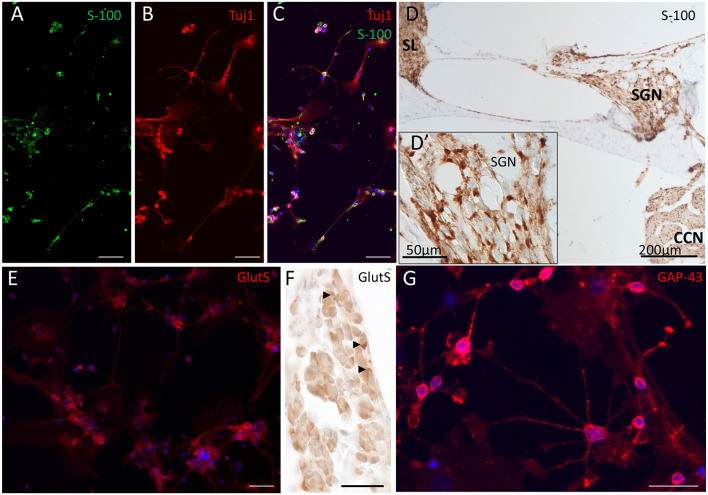
Glial marker expression in differentiated phoenix cells. (A–C) Beta-III-tubulin and S-100 staining 3 days after seeding of phoenix auditory neuroprogenitors. (A) S-100 (green). (B) Beta-III-tubulin (TUBB; red). (C) Composite image with DAPI nuclei staining. (D) S-100 staining in mouse pups cochlear slices. (D′) Inset represents a magnified view of the SGN area and identify Schwann cells as well as satellite glia cells positively stained. (E,F) Glutamine synthetase (GlutS) immunostaining shows presence in several cells mainly in very small satellite cells. (F) Glutamine synthetase in the spiral ganglion of a mouse, 1 day after birth (arrows). (G) GAP-43 immunostaining in differentiating (D3) phoenix cells. Scale bar for (A,B,C,E) = 50 μm. Scale bar for (F) and (G) = 40 μm.